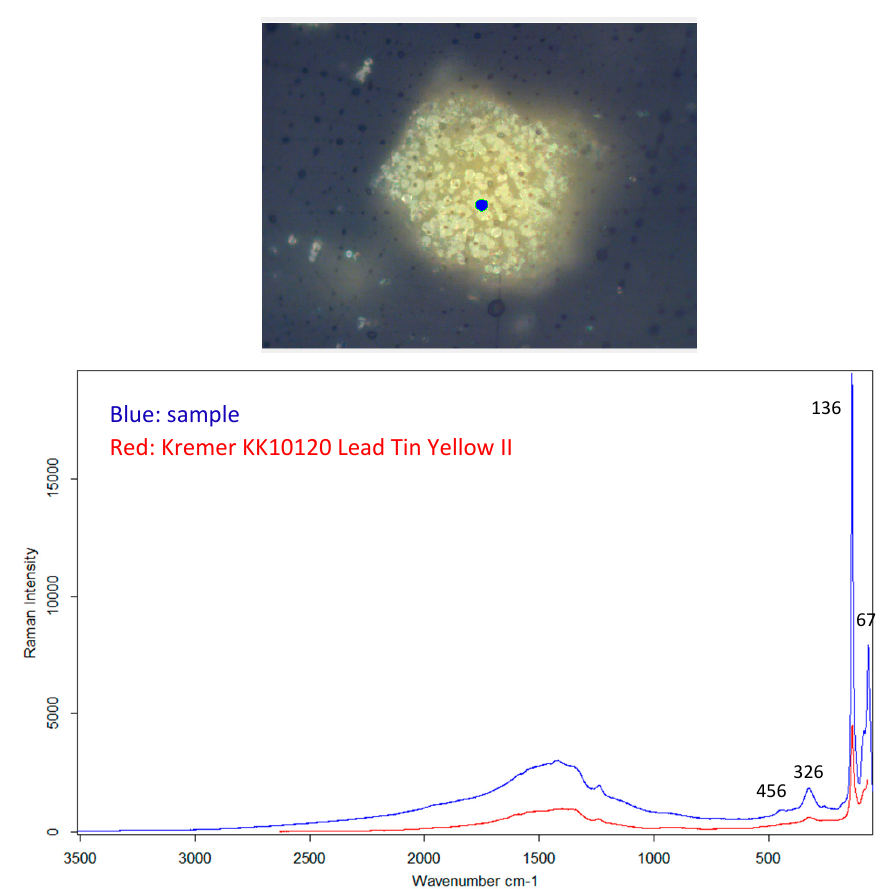
Figure 34. Raman spectrum acquired on subhedral crystals, with bands at 67, 136, 326, and 456 cm − 1 consistent with Lead–Tin Yellow type II, PbSn 1 − x Si x O 3 [55] (DMS_2Bb yellow natron-based Egypt I glass tessera from the Great Mosque of Damascus, Syria—unpublished data [24,25]).